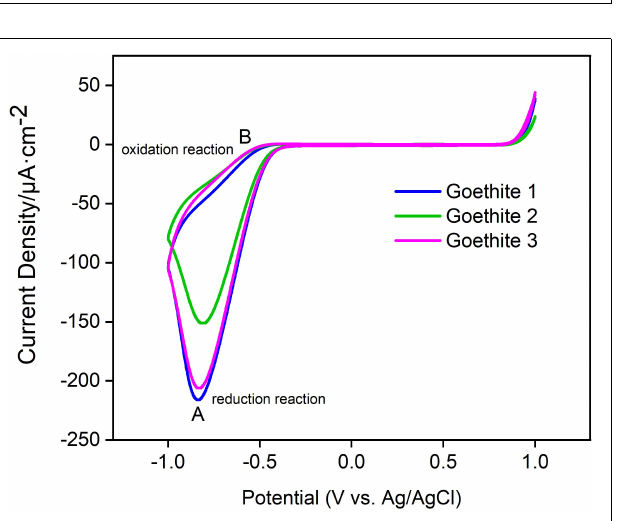
FIGURE 5 | Cyclic voltammetry curves of synthetic goethite electrodes.